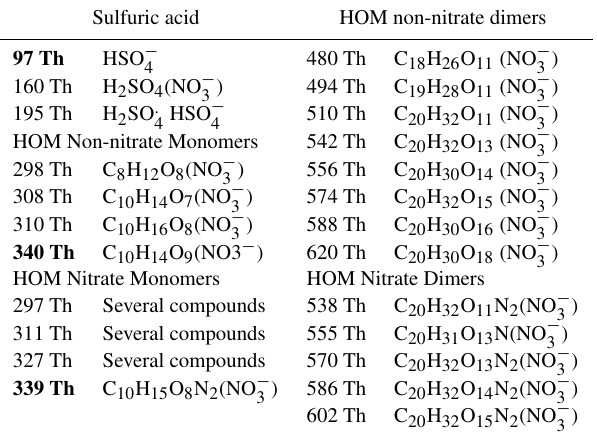
Table 1. The mass peaks selected for analysis and their molecu- lar formulas. Sulfuric acid and HOM monomer peaks were selected based on correlation with the bolded mass peaks and summed to- gether in order to increase the signal-to-noise ratio. HOM nitrate monomer peaks listed as “several compounds” contain HOM ni- trate monomers and radicals, but a single peak cannot necessarily be identified as the main